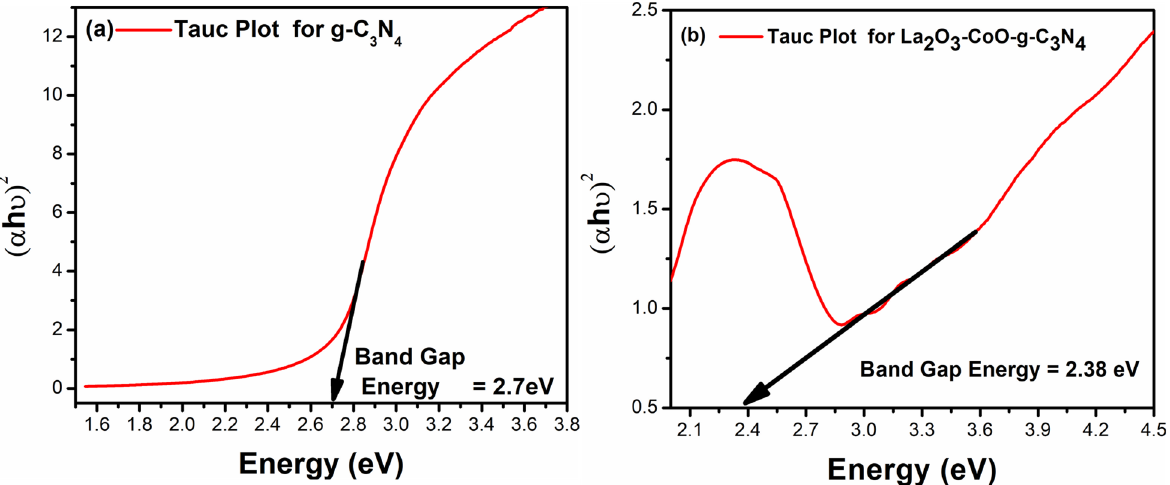
Figure 3. ( a ) Bandgap energy ( E g ) calculations for g-C 3 N 4 and ( b ) bandgap energy of La 2 O 3 –CoO–g-C 3 N 4 nanocomposites calculated by UV–visible spectroscopy and employing the Tauc plot method.